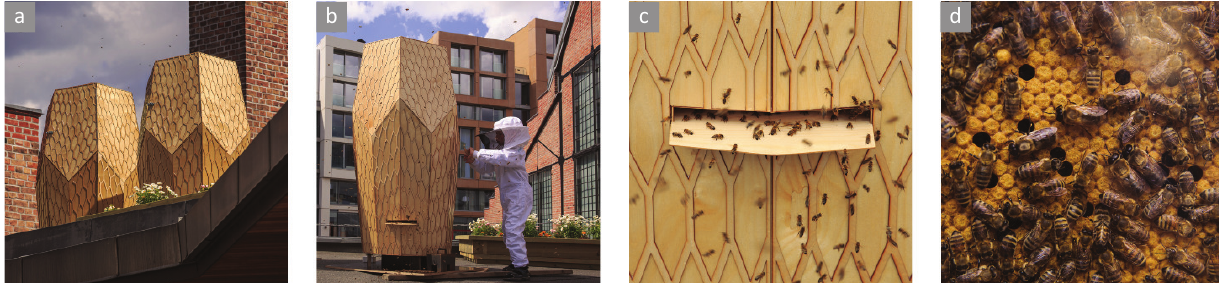
Figure 5. Vulkan precinct in Oslo: (a), (b), (c), and (d) beehive designed by Snøhetta. Source: Photos by Morten Brakestad